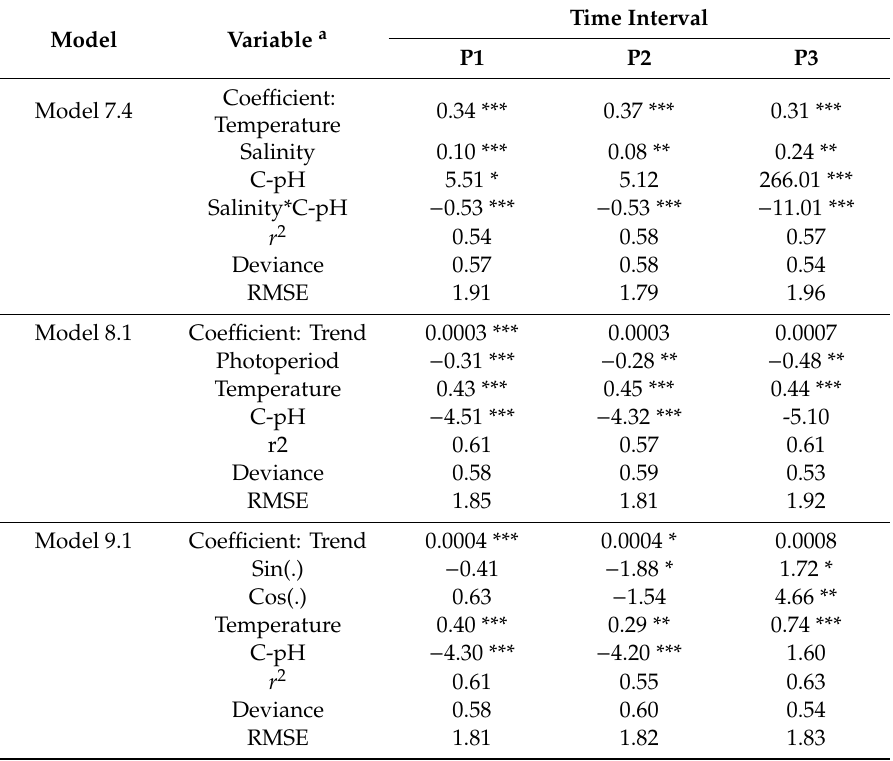
Table 5. The performance of three selected models: environmental model (Model 7.4), hybrid model (Model 8.1), and harmonic regression model (Model 9.1) for three time periods: full (P1), training (P2), and testing (P3)